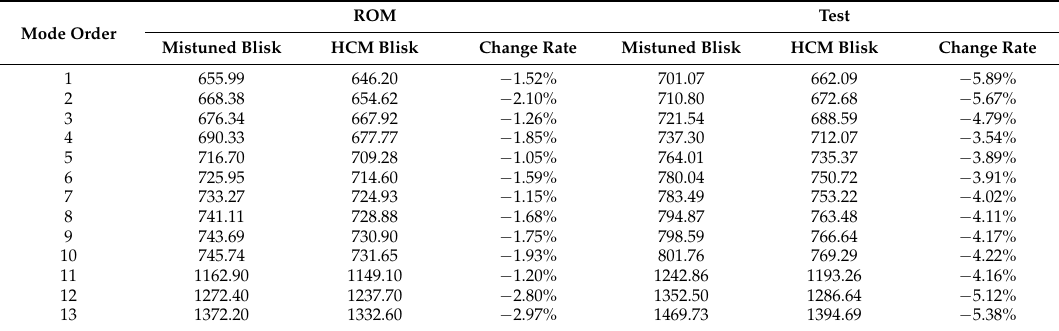
Table 4. Natural frequencies of mistuned blisk and HCM blisk (Hz).